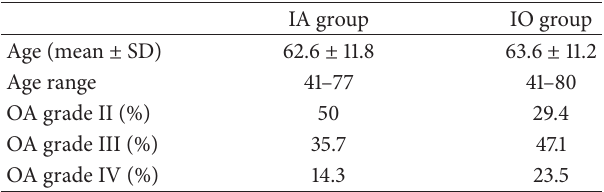
Table 1: Patients included in the study and their clinical OA grade. IA group IO group Age (mean ± SD) 62.6 ±